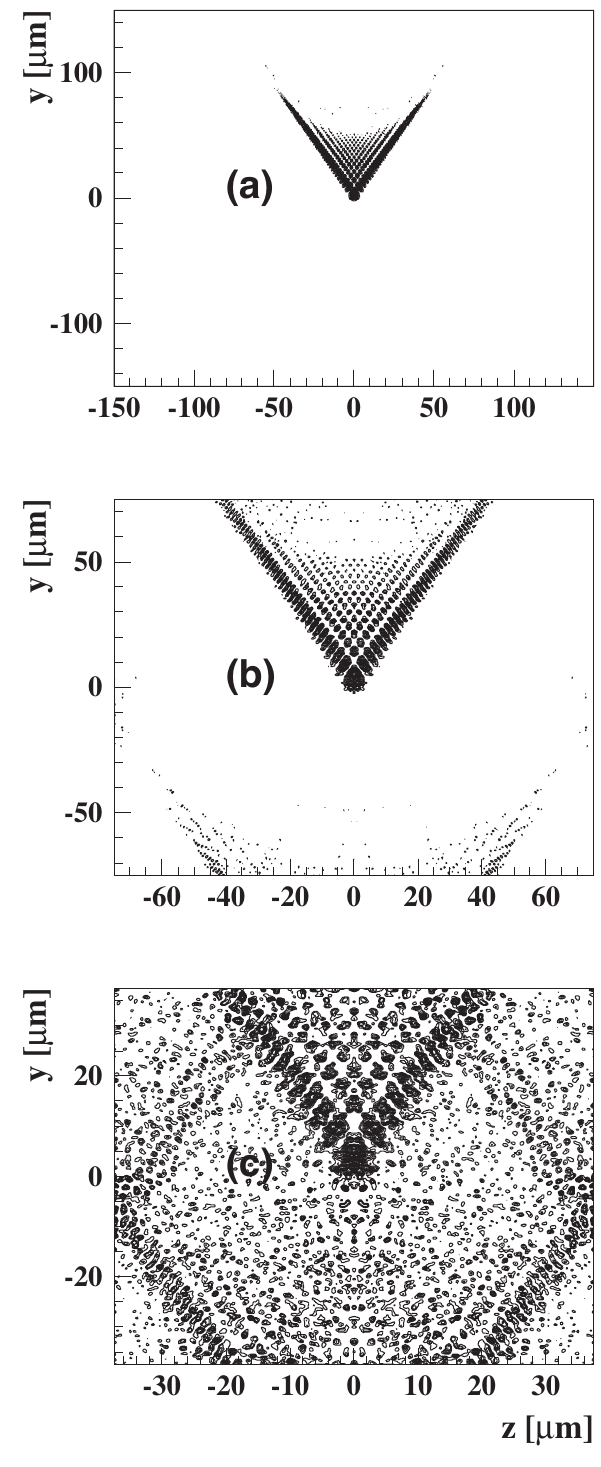
FIG. 11. Contour plots of the intensity distribution in the image plane as simulated with Fourier optics. The demagnifica- tion is 20:1 , the source and image distances are 10 000 and 500 mm, and the grazing angle is 10 (cid:14) . Parts (a), (b), and (c) differ only in the image size. Numerical errors show up if the size has been chosen too small which is due to the periodic behavior of the Fourier